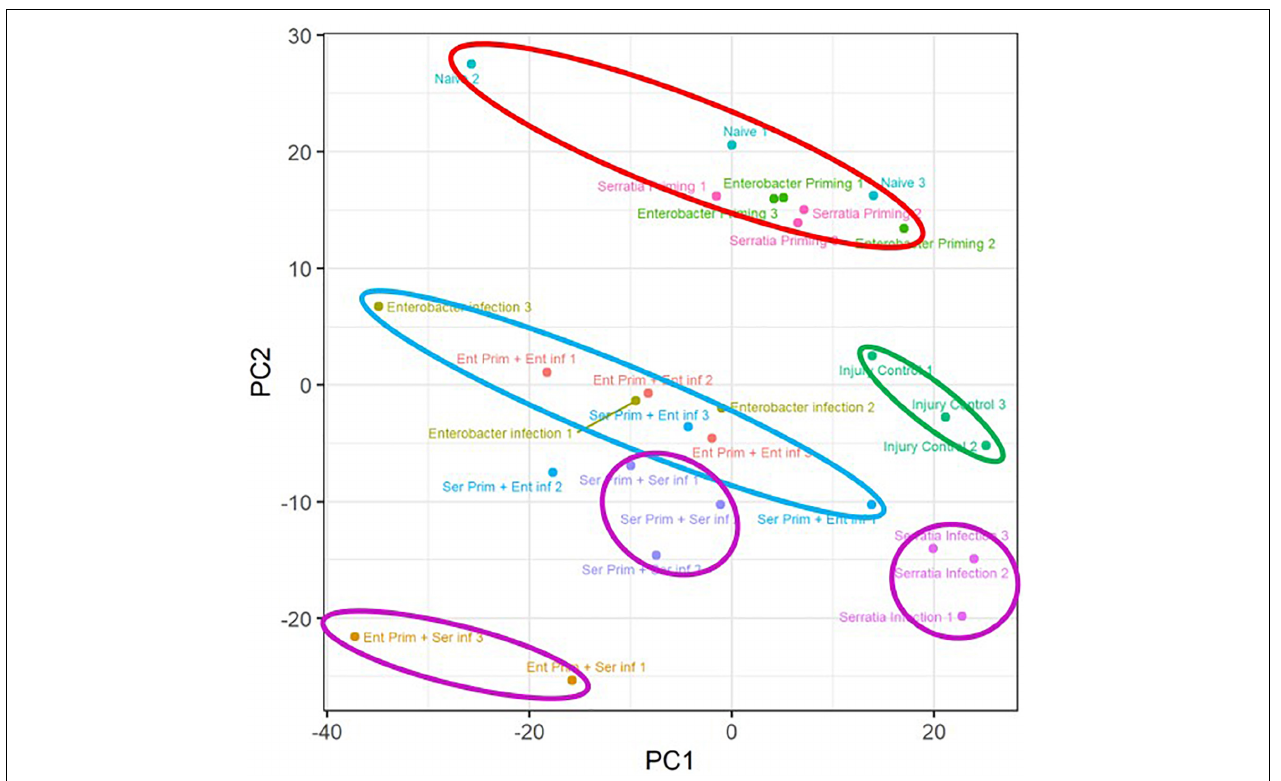
FIGURE 4 | Overview of the priming effects on the transcriptomic response to respective bacterial challenges. Transcriptome replicates from primed cohorts without challenge were marked with a circle in red. Replicates of injury controls were marked with a circle in green. Replicates of Enterobacter challenged cohorts with respective priming were marked with a circle in blue. Replicates of Serratia challenged cohorts with respective priming were marked with a circle in purple. Naive, cohorts with native microbiota; Enterobacter infection, Enterobacter challenged cohort with native microbiota; Serratia infection, Serratia challenged with native